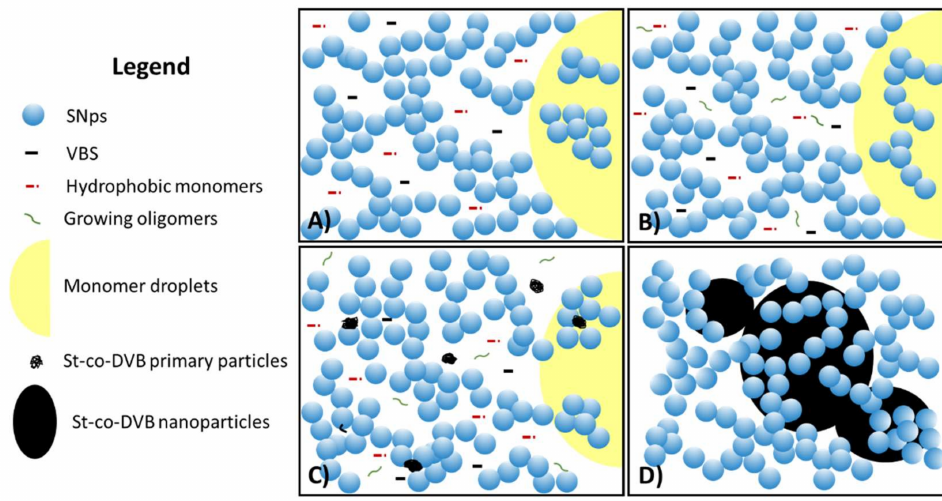
Figure 3. Schematic representation of polymerization via limited homogeneous coagulative nucle- ation. ( A ) Hydrophobic monomers and VBS dissolved in the emulsion aqueous phase where the SNps form a 3D network. ( B ) Oligomer formation in the presence of dissolved monomers. ( C ) Formation of primary polymer particles growing by monomer swelling. ( D ) Polymer microspheres partially covered by